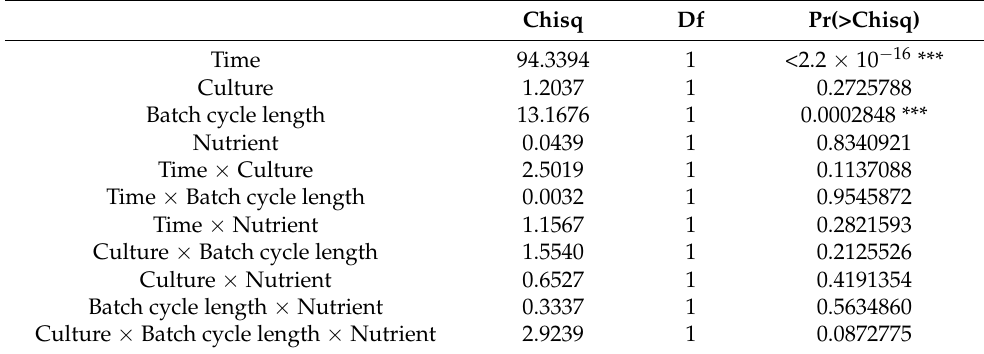
Table 8. Analysis of deviance table of Type II Wald χ 2 tests for generalized linear mixed-effects model using the proportion of C. affinis genotype B67 as response variable. Stars show significance level of the test; *** p <